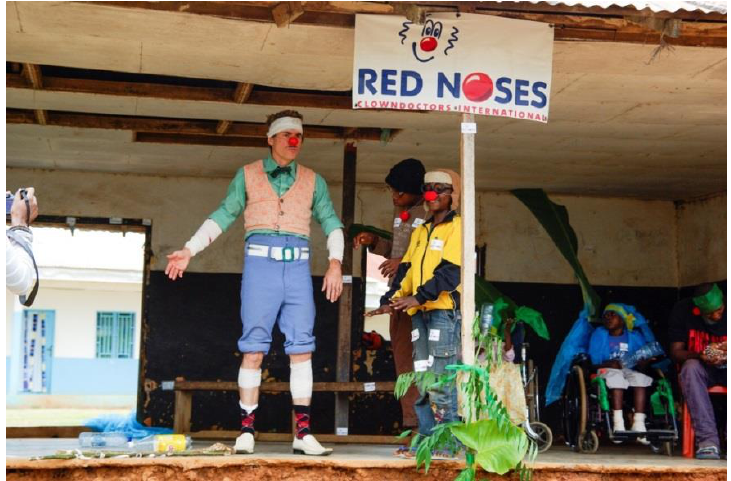
Figure 5. Final performance of “Emergency Smile” in Akonolinga,